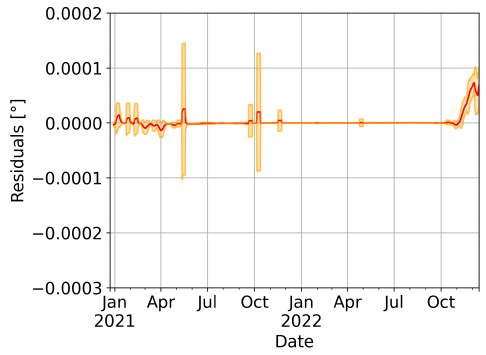
Figure 14. Iterative model: T10 residuals.